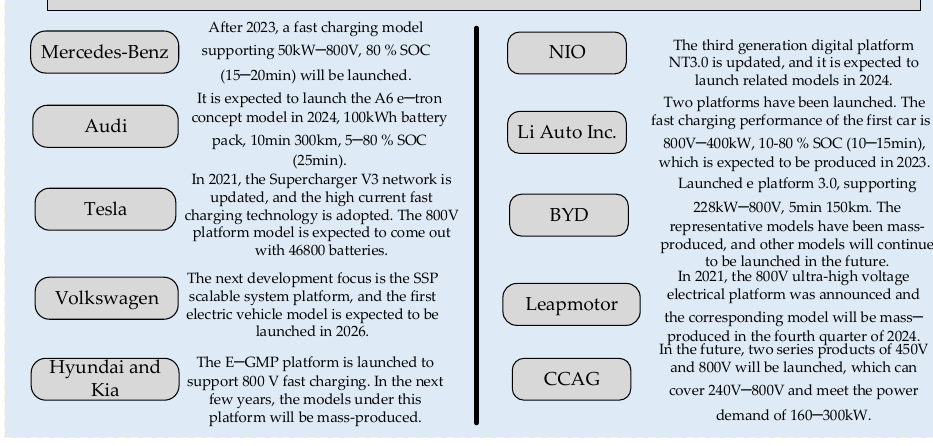
Figure 23. Strategic planning of the charging systems of some well-known car